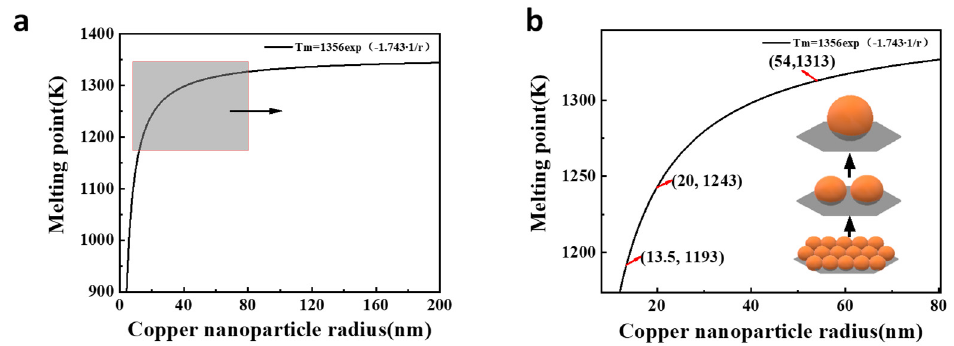
Figure 6. ( a ) The melting points of copper nanoparticles and ( b ) the segregation and growth of copper nanoparticles deposited on the diamond surface with increasing sintering temperature.